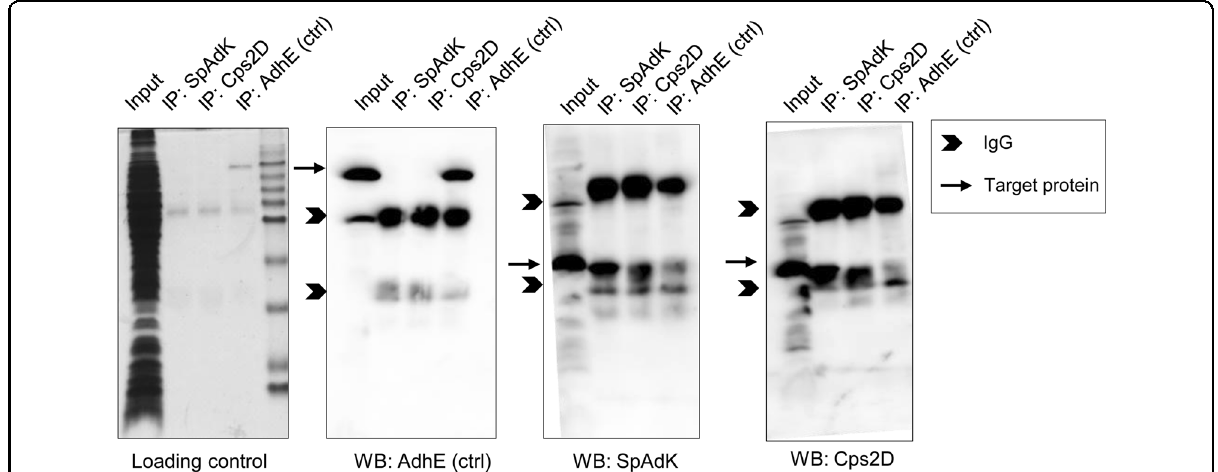
Fig. 4 SpAdK interacts with Cps2D. Lysates (100 µg) were used for immunoprecipitation with 5 µL of anti-SpAdK, anti-Cps2D, or anti-AdhE (control). Immunoprecipitated proteins were subjected to western blotting. For western blotting, proteins were detected with anti-SpAdK, anti- Cps2D, or